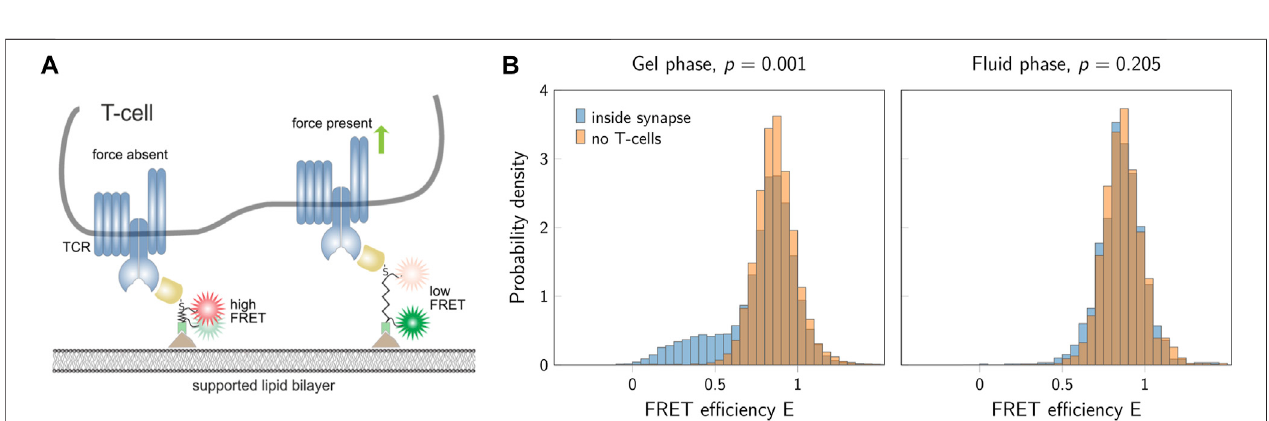
FIGURE 10 | Comparison of permutation test and block permutation test. (A) Representative simulated FRET ef fi ciencies for 10 simulated trajectories of group A (left,blue)and B (right,orange).Bothgroupsweresimulatedusingthesame parameters(see Section7 ). (B) Representativerandompermutationofthedatafrom panel (A) . (C) Representativeblockpermutationofthedatafrompanel (A) .Here,datafromindividualtrajectoriesiskepttogether. (D,E) Histogram of p -valuesobtainedforthe standardpermutationtestpanel (D) andtheblockpermutationtestpanel (E) .Asatestsummarystatisticsthedifferencebetweenthemeansofthegroups A and B was taken. As both groups were simulated using the same parameters, the null hypothesis of no difference between the groups was ful fi lled. Importantly, only the block permutation test provides a uniform distribution and hence a valid p -value.